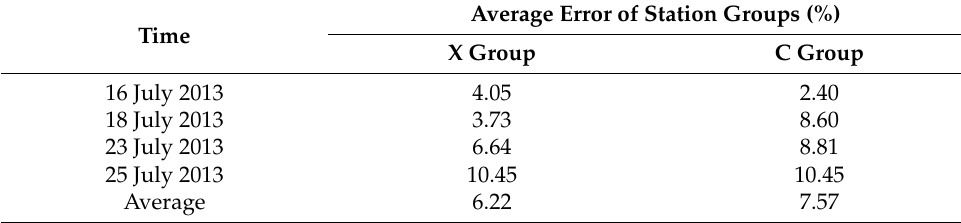
Table 2. The average error of TN for July 16–18